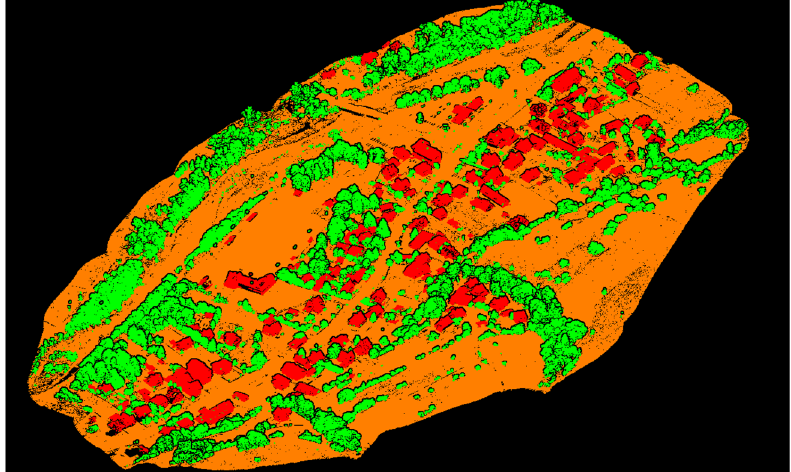
Figure 13. Classified point cloud from the L1 scanner.